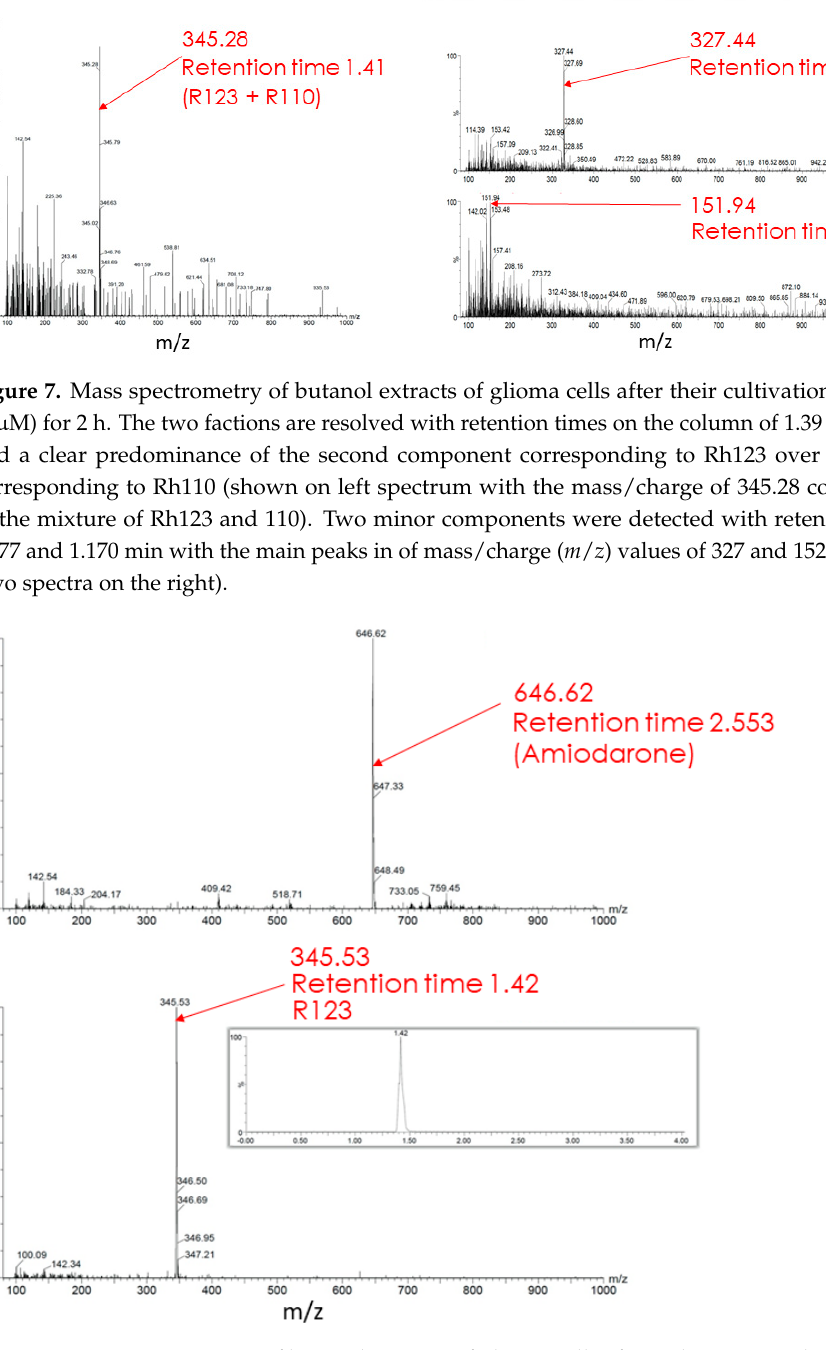
Figure 8. Mass spectrometry of butanol extracts of glioma cells after cultivation with Rh123 (2 µM) and amiodarone (2 µM). Only Rh123 + 110 and amiodarone molecules are detected (with retention times of 1.42 and 2.553 and mass/charge of 345.53 (bottom) and 646.62 (top) correspondingly).